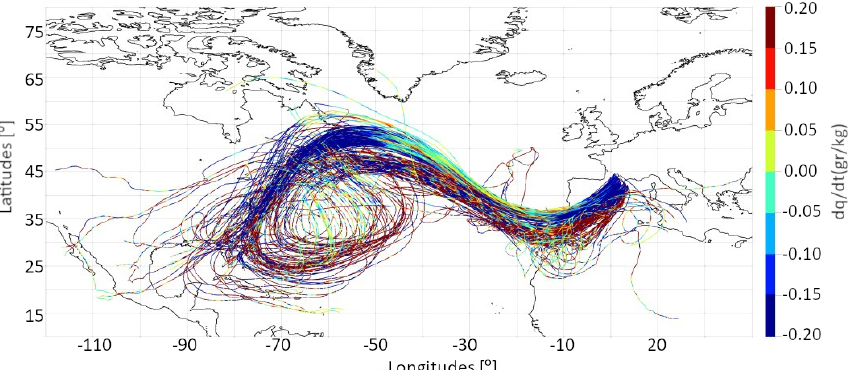
Figure 6. A period of 11d backtracking for a subset of particles precipitating over the region of interest between 12:00–15:00UTC on 7 November. Color corresponds to moisture exchanges along the paths followed by